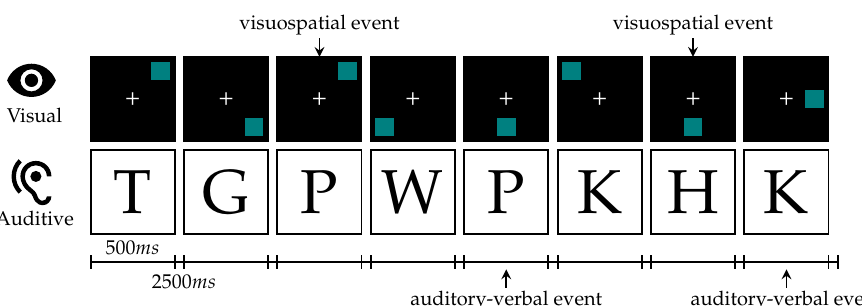
Figure 5. Example of visuospatial and auditory-verbal stimuli, presented during dual n -back test with level 2 (dual-task 2-back test) [20]. Stimuli are presented for 500 ms followed by an inter- stimulus-interval of 2500 ms. Example with two visuospatial and two auditory-verbal repetitions. The expected reactions are presented by arrows below and above the figure.